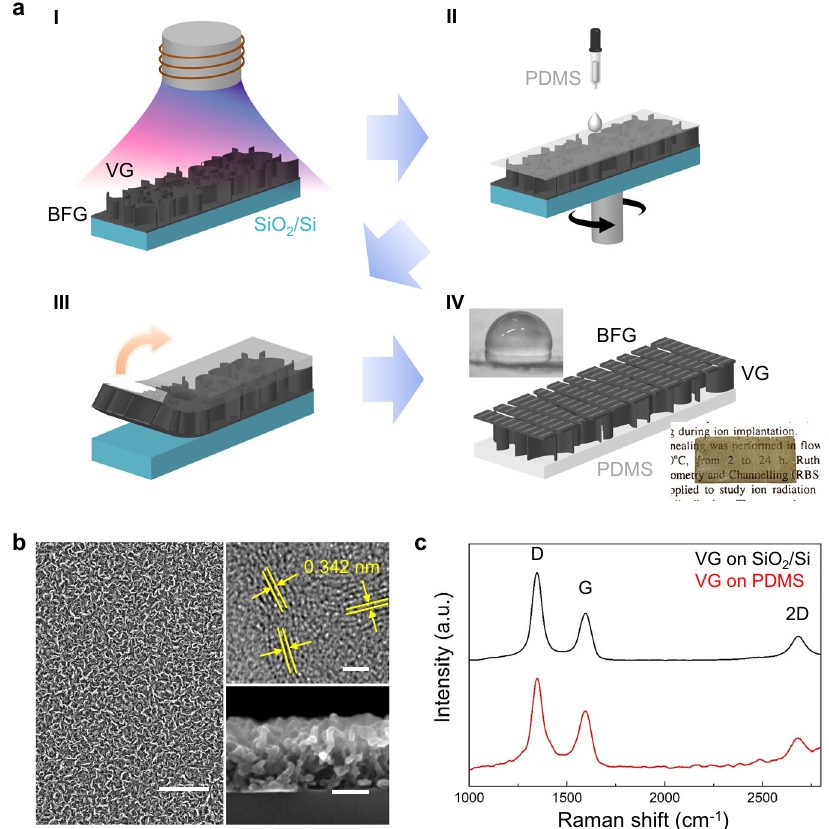
Fig. 1 Fabrication of a VG on PDMS strain sensor and its characterization. a Schematic illustration for the fabrication of a VG on PDMS strain sensor. A pristine VG fi lm is directly grown on a SiO 2 /Si substrate by PECVD (step I). A BFG layer is formed between the VG and SiO 2 substrate during the initial VG growth. A dilute PDMS mixture (10:1) is drop cast onto the VG fi lm, followed by spin-coating (step II). The PDMS fi lm is degassed using a vacuum desiccator and cured for 2 h at 70 °C. After curing, PDMS/VG is mechanically peeled off the SiO 2 substrate (step III). When fl ipped over, the fi nal product, BFG/VG on PDMS is obtained (step IV). Insets of step IV: contact angle optical image of a water droplet on VG (upper left) and photograph (lower right) of VG on PDMS after removal from the SiO 2 substrate. b SEM image of an as-grown VG fi lms on a SiO 2 substrate. Scale bar, 3 μ m. The top inset shows an HR-TEM image of a VG fi lms, con fi rming the interplanar spacing of 0.342 Å, comparable to that of graphite. Scale bar, 2 nm. The bottom inset shows a cross-sectional view of a VG fi lms on SiO 2 , revealing a tufted 3D network structure. Scale bar, 100 nm. c Raman spectra of VG on SiO 2 /Si and PDMS. The clear peaks at around 1350 cm − 1 (D peak), 1585 cm − 1 (G peak), and 2690 cm − 1 (2D peak) are observed for both